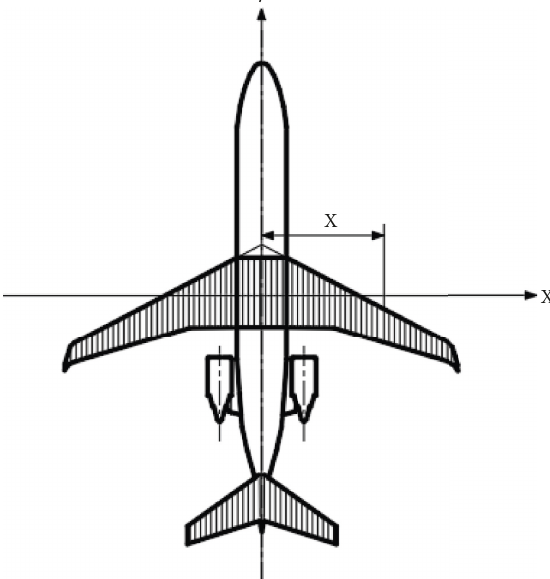
Figure 5: Strip model of CRJ-900 stress